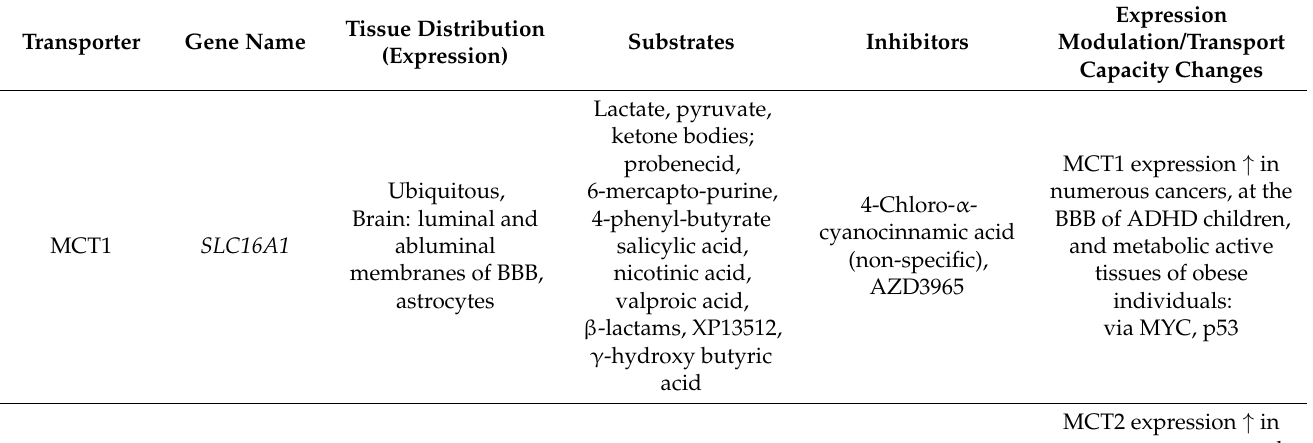
Table 4. Tissue distribution, substrates, inhibitors, and expression/function modulators of MCT1–4 and